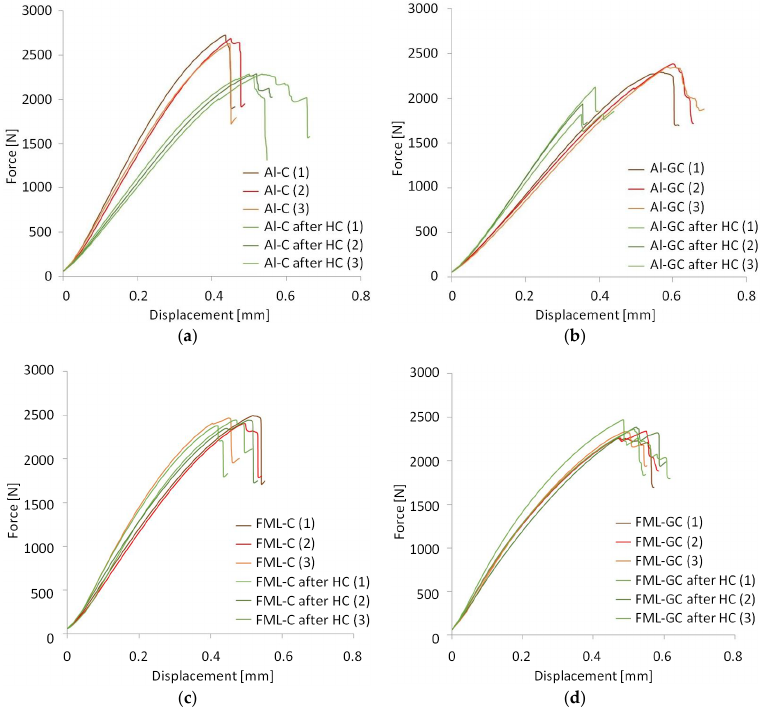
Table 1. Interlaminar shear strength values for tested laminates.